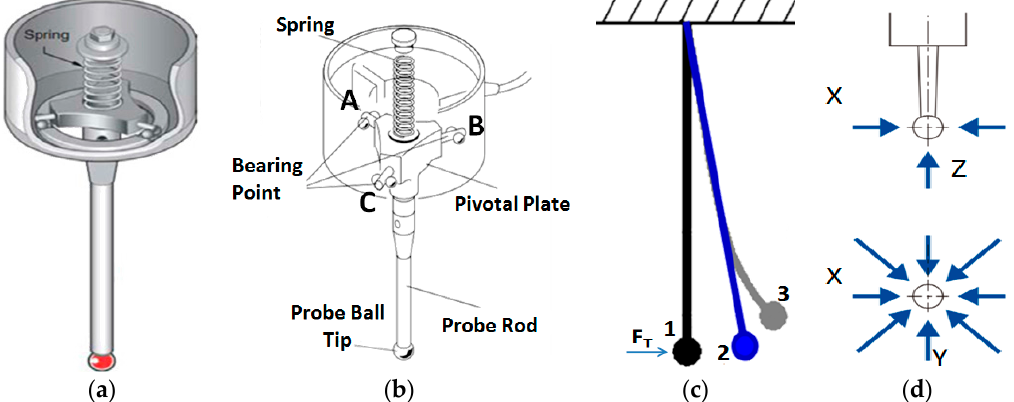
Figure 2. Structure of the touch trigger probe: ( a ) 3D structure drawing of the probe; ( b ) schematic diagram of each part of the probe; ( c ) stress deformation diagram of the probe under the trigger force F T ; ( d ) diagram of five degrees of freedom distribution of the probe.